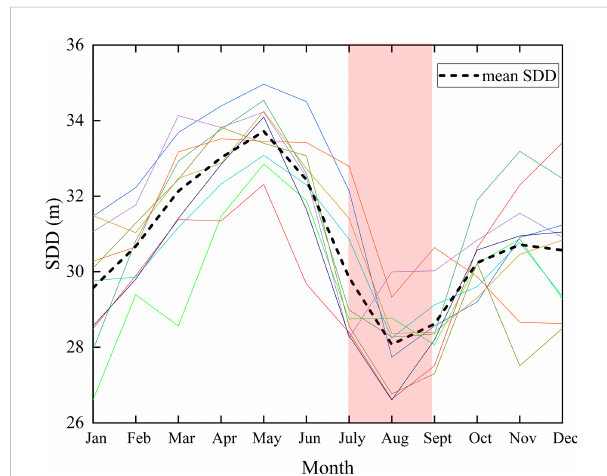
FIGURE 2 Annual cycle of SDD calculated from 2011 to 2020 in the study area. Different color lines represent the SDD of different years. Black dashed line represents the mean value of SDD. The red area represents the low value of SDD from July to